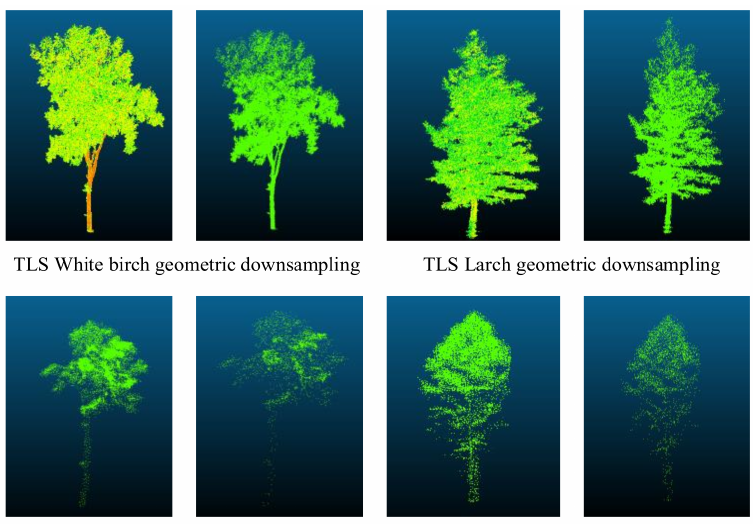
Figure 8. Tree point cloud data processed by geometric